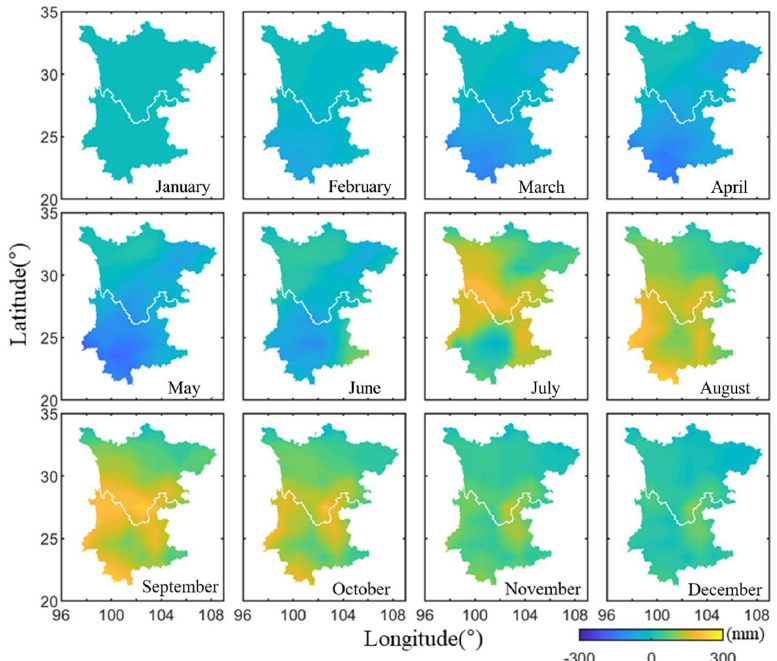
Figure 8. Monthly variations (2011) of the TWS in Sichuan-Yunnan estimated by GRACE.